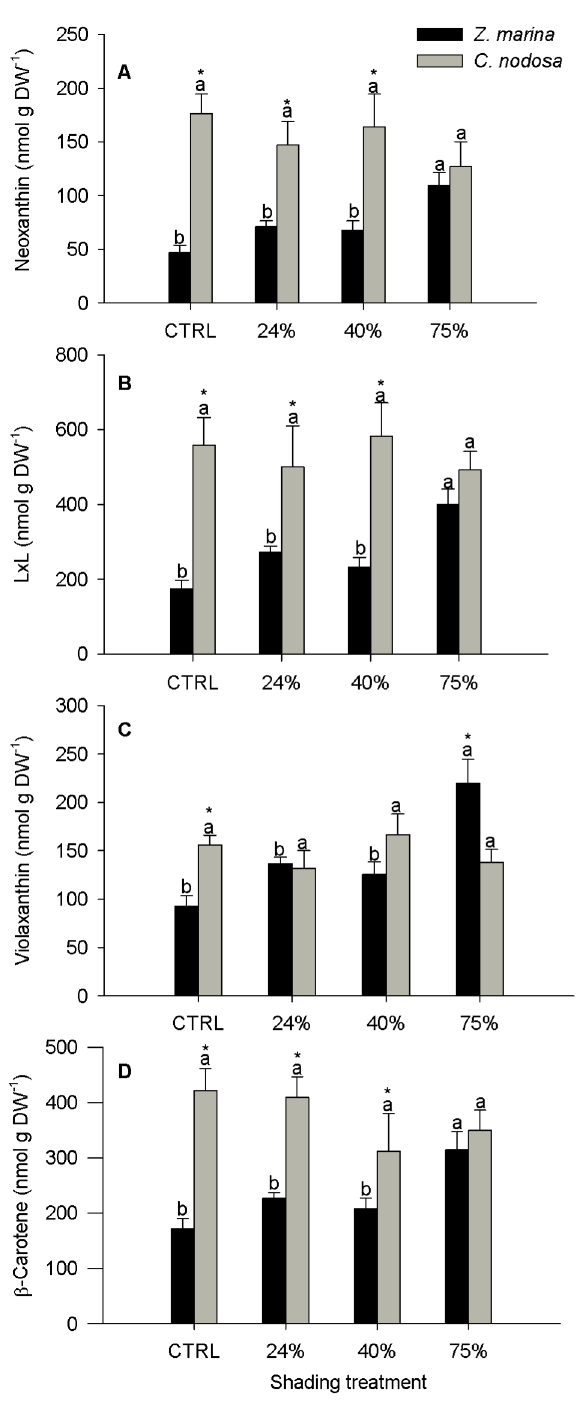
Figure 3. Foliar content of photosynthetic pigments in Zostera marina and Cymodocea nodosa . Plants submitted to shading treatments of 24, 40 and 75% of naturally available photosynthetically active radiation (CTRL). A- Neoxantin, B - Lutein plus Lutein epoxide (LXL), C -Violaxanthin, D – b -Carotene. Different letters indicate significant differences between treatments, * indicates differences between species (n=5, p , 0.05).